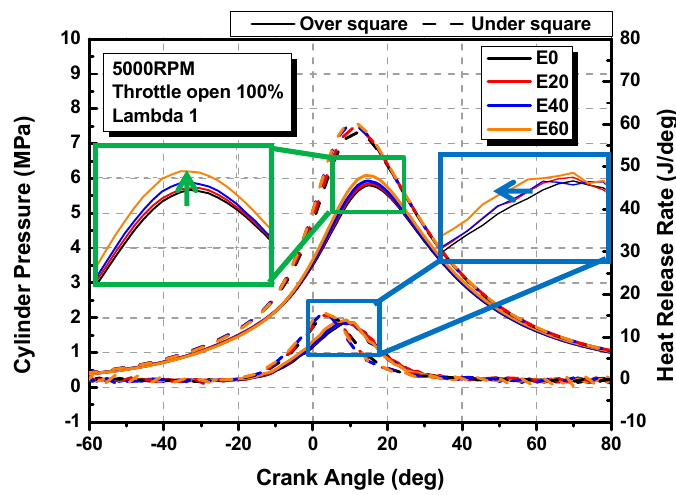
Figure 7. In-cylinder pressure and heat release rate for over- and under-square engine vs. ethanol blending ratio.